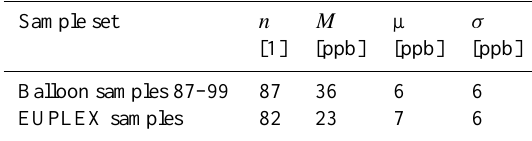
Table 2. Differences between the individual rescaled hydrogen mixing ratio measurements and the combined “final” results. n : number of samples in respective sample set; M : Maximum differ- ence; µ: average difference; σ : standard deviation of